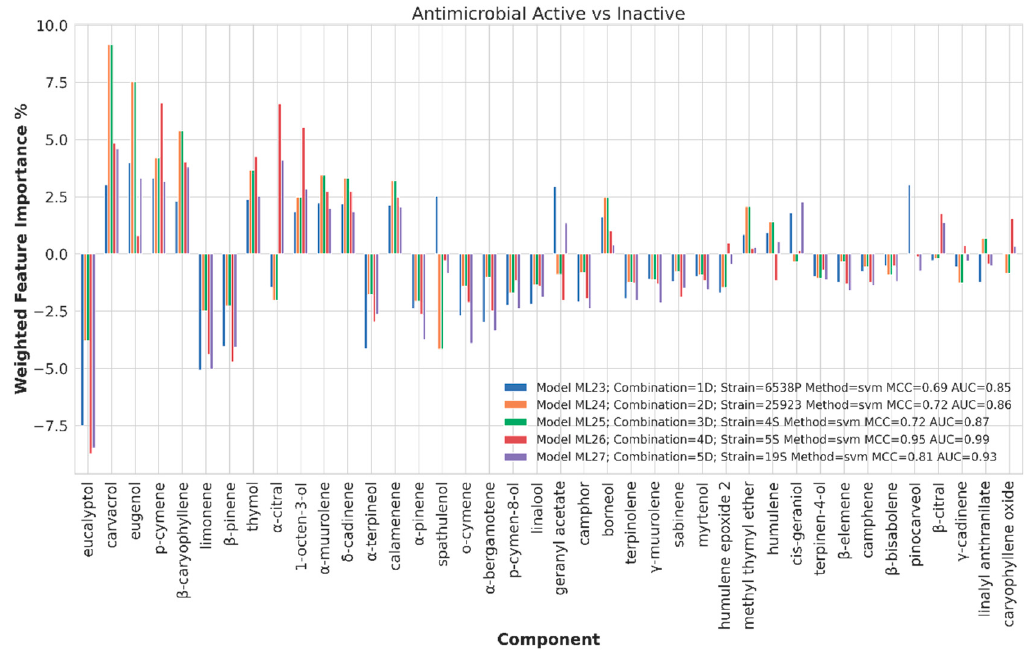
Figure 9. Weighted feature importance (WFI) plot for models obtained on active and inactive binarized dataset antimicrobial data. Positive bars are associate with antimicrobial activity, whereas negative bars indicate components with potential antisynergistic effect on S. aureus spp.